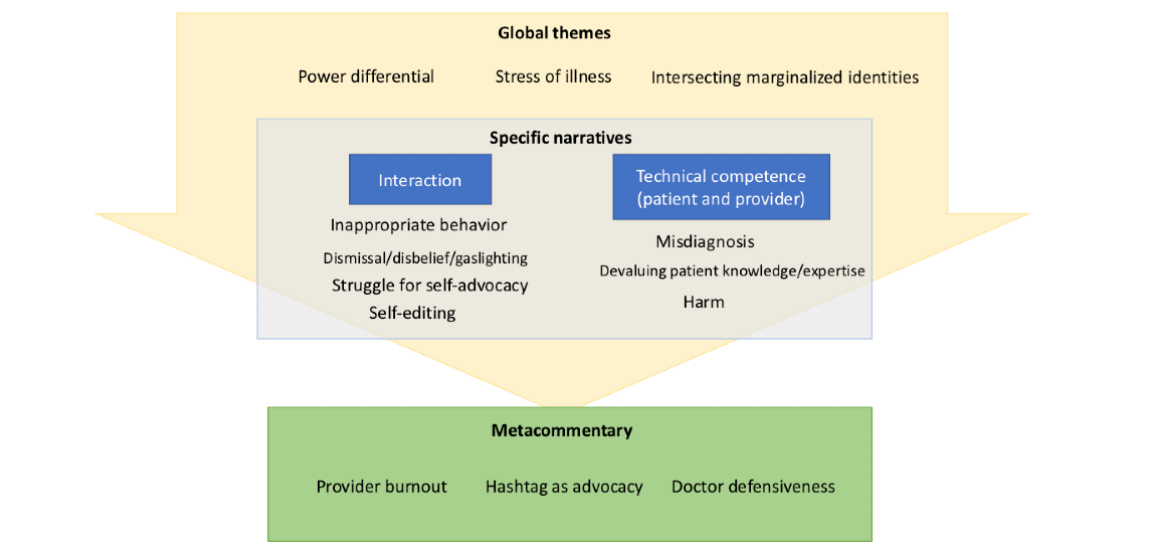
Figure 1. Map of major themes identified in Twitter hashtag.